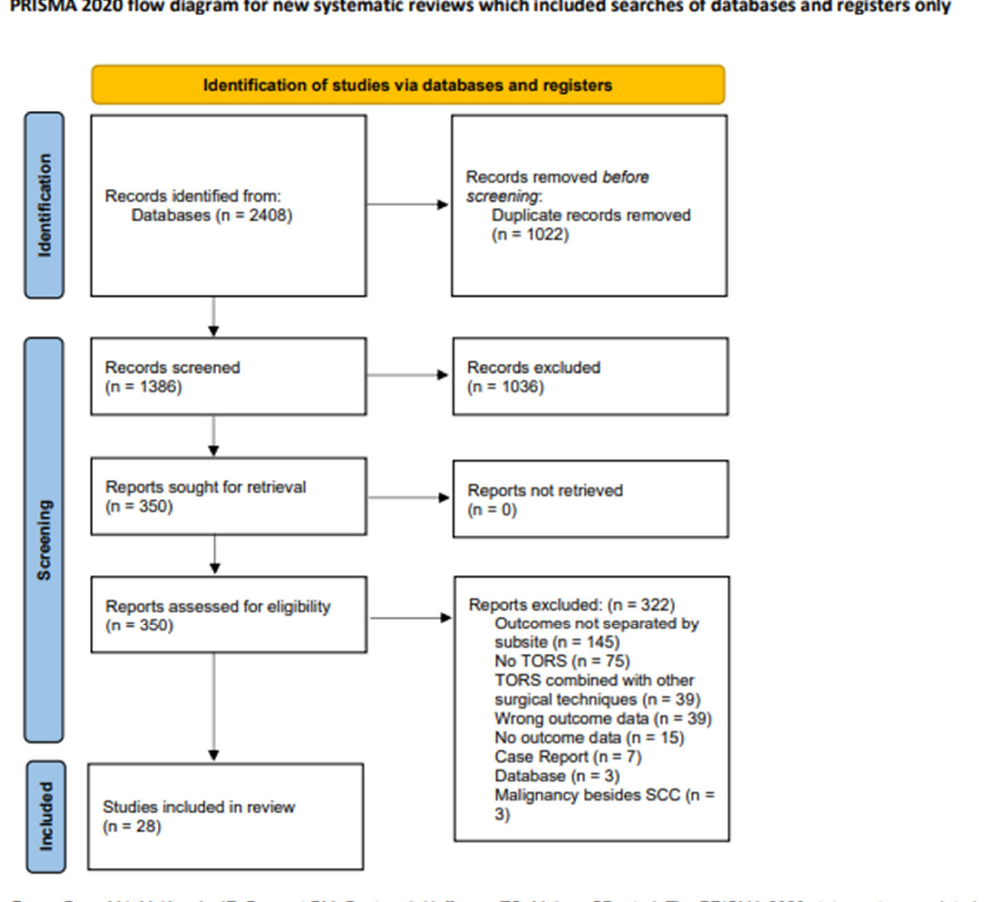
Figure 1. PRISMA flowchart of study selection.